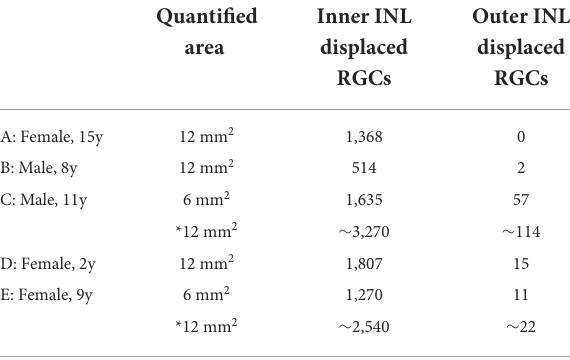
TABLE 3 Number of displaced RGCs in central marmoset